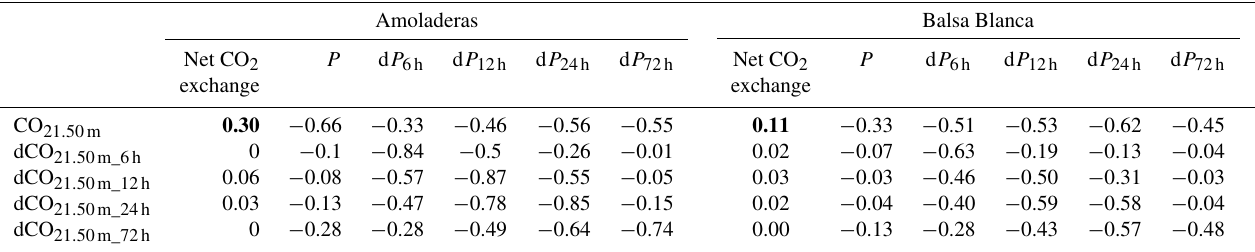
Table 7. Spearman correlation coefficients ( r s ) for every paired simple correlation among maximum quality net CO 2 exchange fluxes (µmolm − 2 s − 1 ), absolute and differential pressure (hPa) at 6, 12, 24 and 72h time step and absolute and differential CO 2 molar frac- tion measured at 1.50m below ground (ppm) at the same time steps. Bold values represent the highest correlation coefficients, while shaded ones denotes nonsignificant relationships ( p -values >